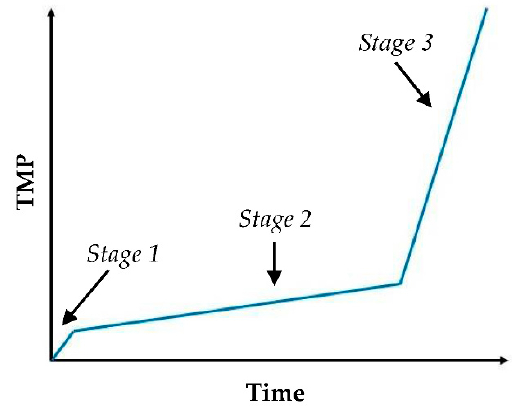
Figure 2. Evolution of Trans-Membrane Pressure (TMP) during filtration under constant flow rate conditions in MBRs.